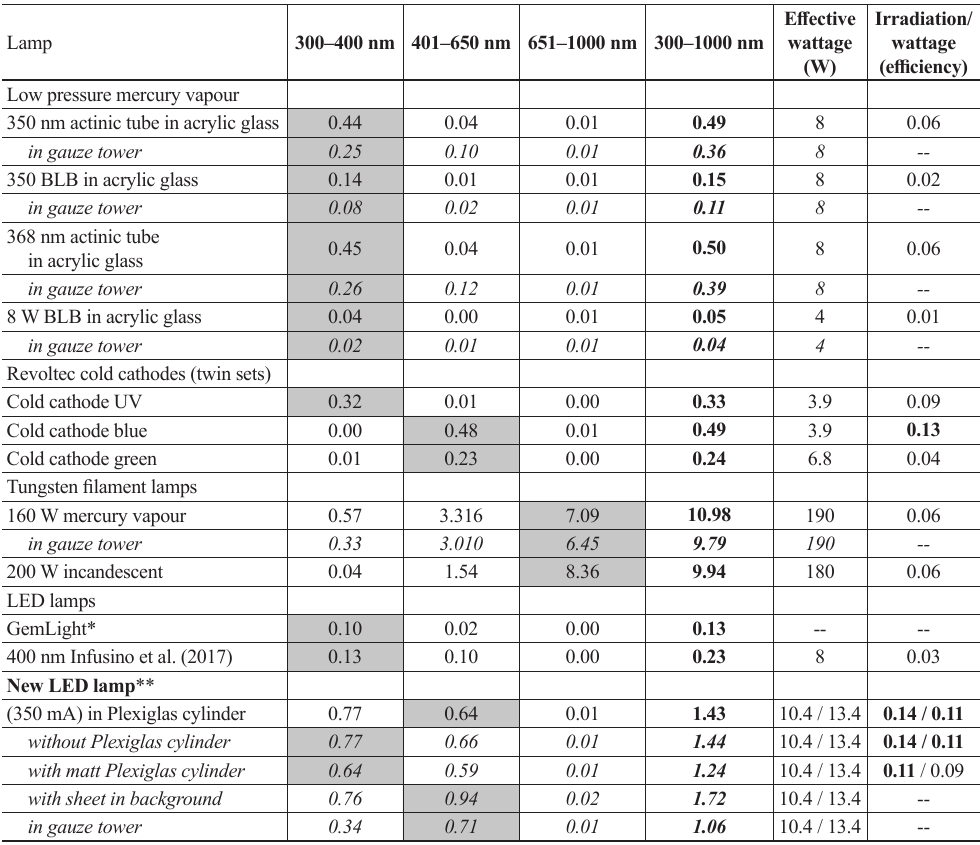
Table 1. Irradiation of selected lamps and LEDs at wavelengths between 300 and 1000 nm, measured at a distance of 50 cm. A full list is provided in Appendix 1. Italics : Measurement of lamp within a gauze tower. Grey cells: wavelength band with highest irradiance. *Unlike other lamps in the test, the GemLight emits only into a single direction (max. 180°). ** Wattage and efficiency of the new LED lamp depend on the input voltage; Values are provided for 12 V and 5 V DC input,